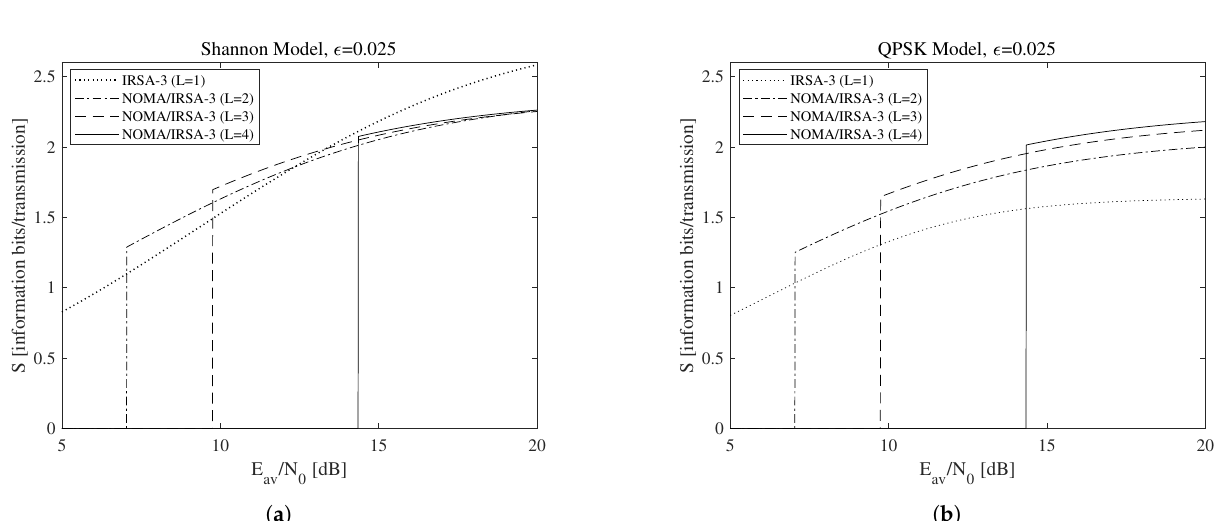
Figure 6. Throughput as a function of the available average SNR for (cid:101) = 0.025: ( a ) Shannon bound, ( b ) QPSK